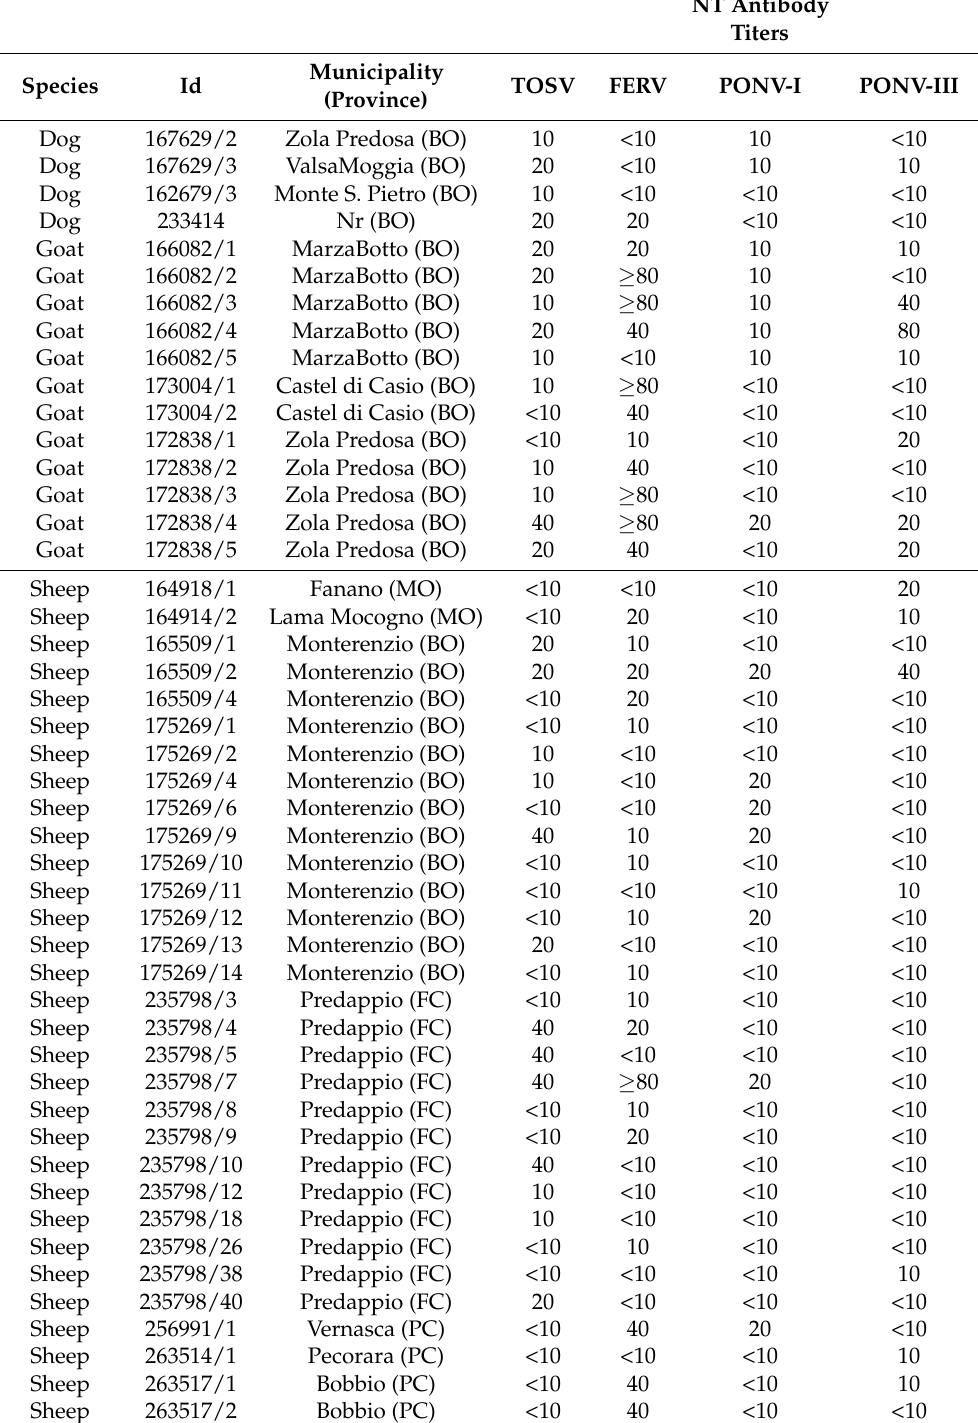
Table 1. Neutralizing antibody titers against four phlebovirus